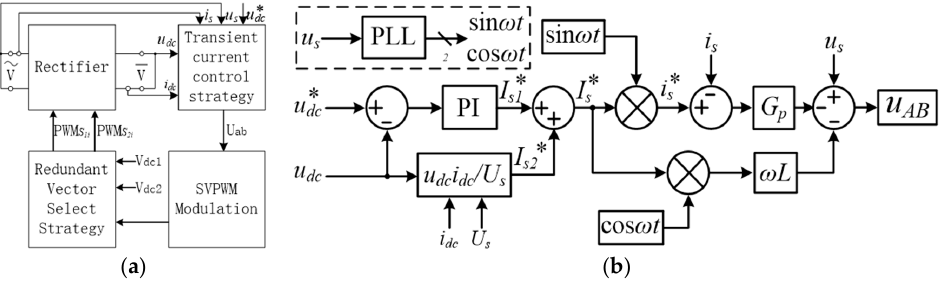
Figure 3. ( a ) Control algorithm; ( b ) transient current control strategy.